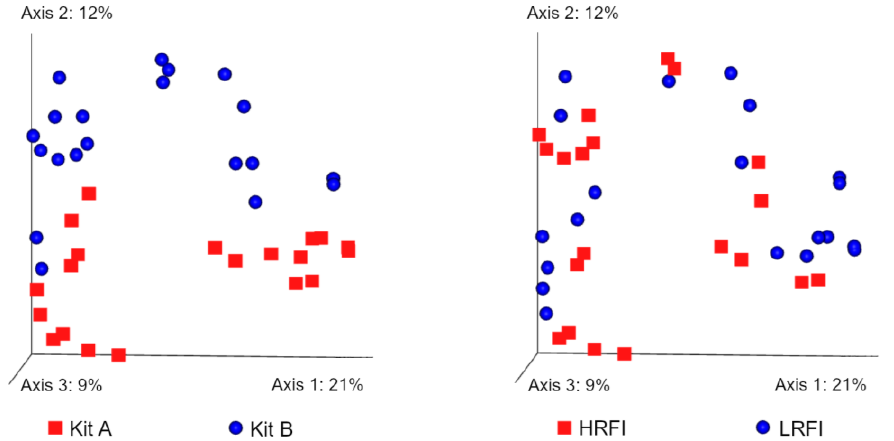
Figure 6. Principal coordinate analysis (PCoA) plots showing Bray–Curtis distances. The separation of samples based on the DNA extraction method is much more evident compared to the separation of samples based on RFI levels. The strong effect of DNA extraction method was also observed in other beta diversity metrics.